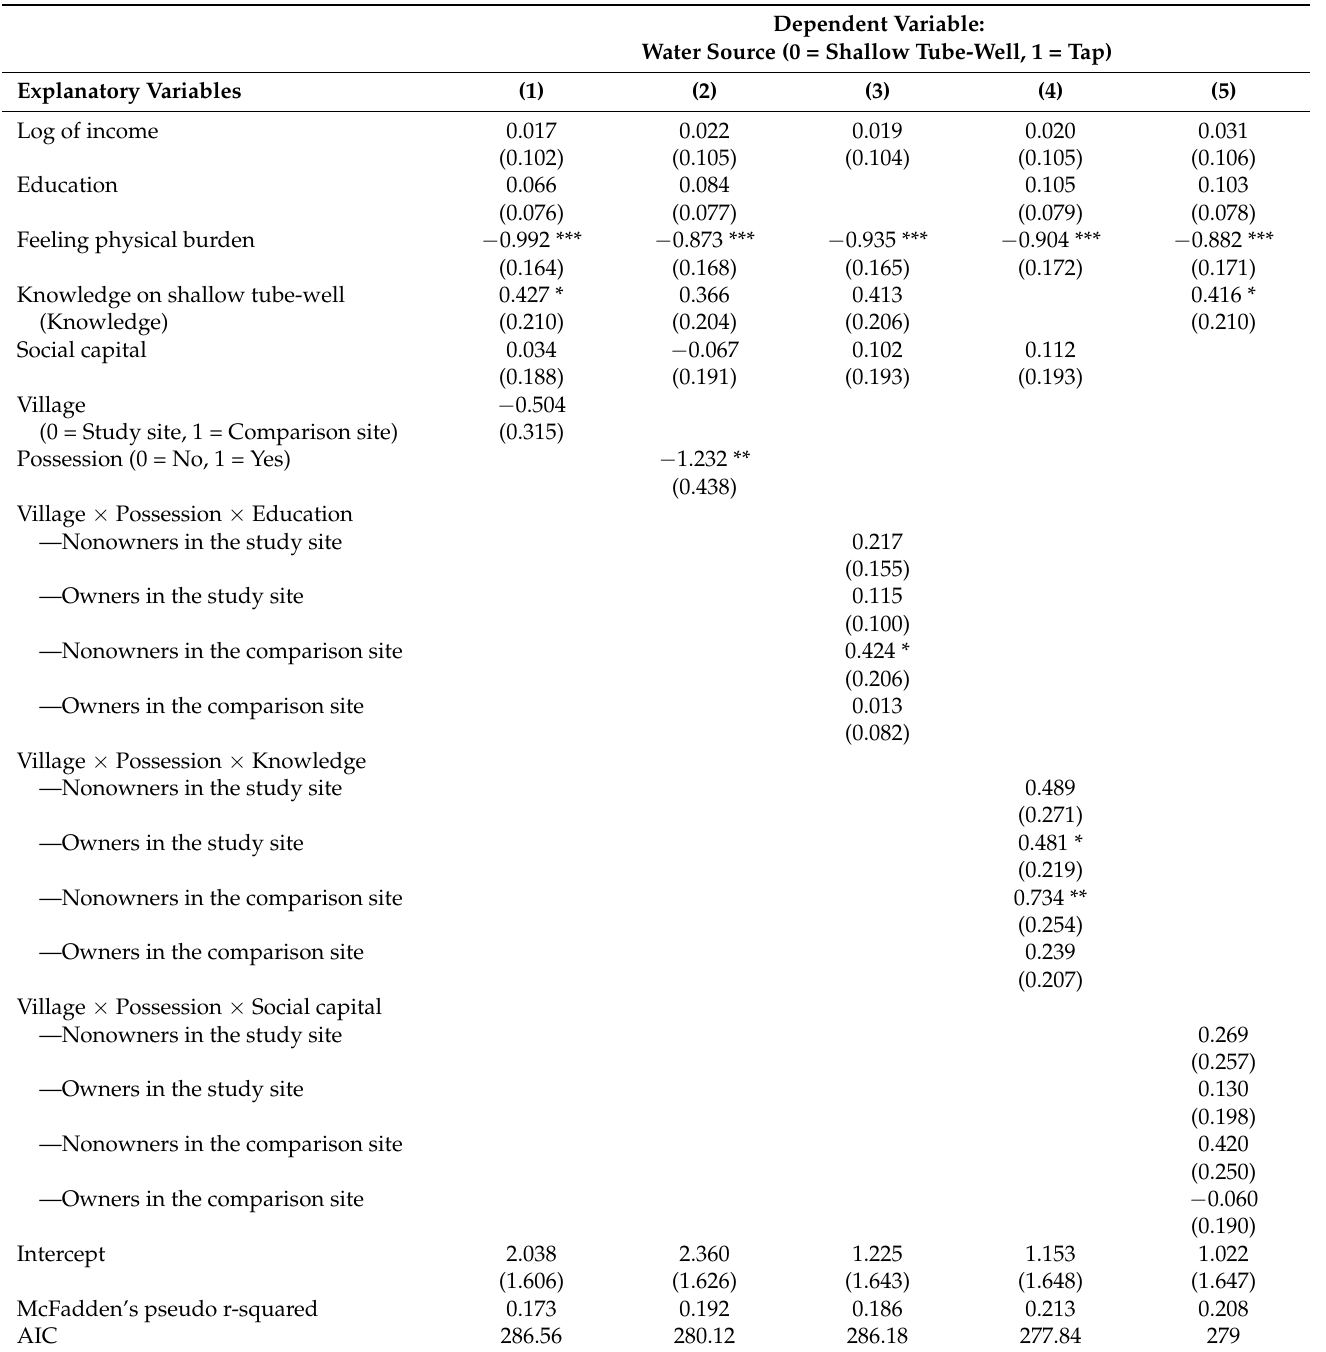
Table 7. Logistic regression results for determining likelihood of cooking water source selection (N = 256) 1 .